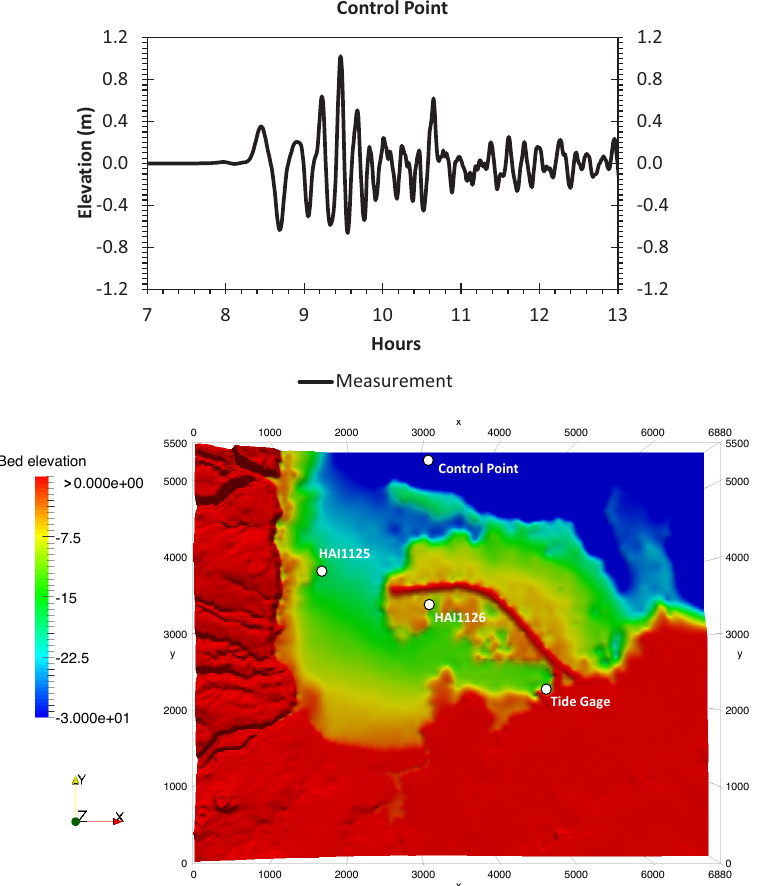
Figure 14. Case 4: bathymetry for simulation and the boundary